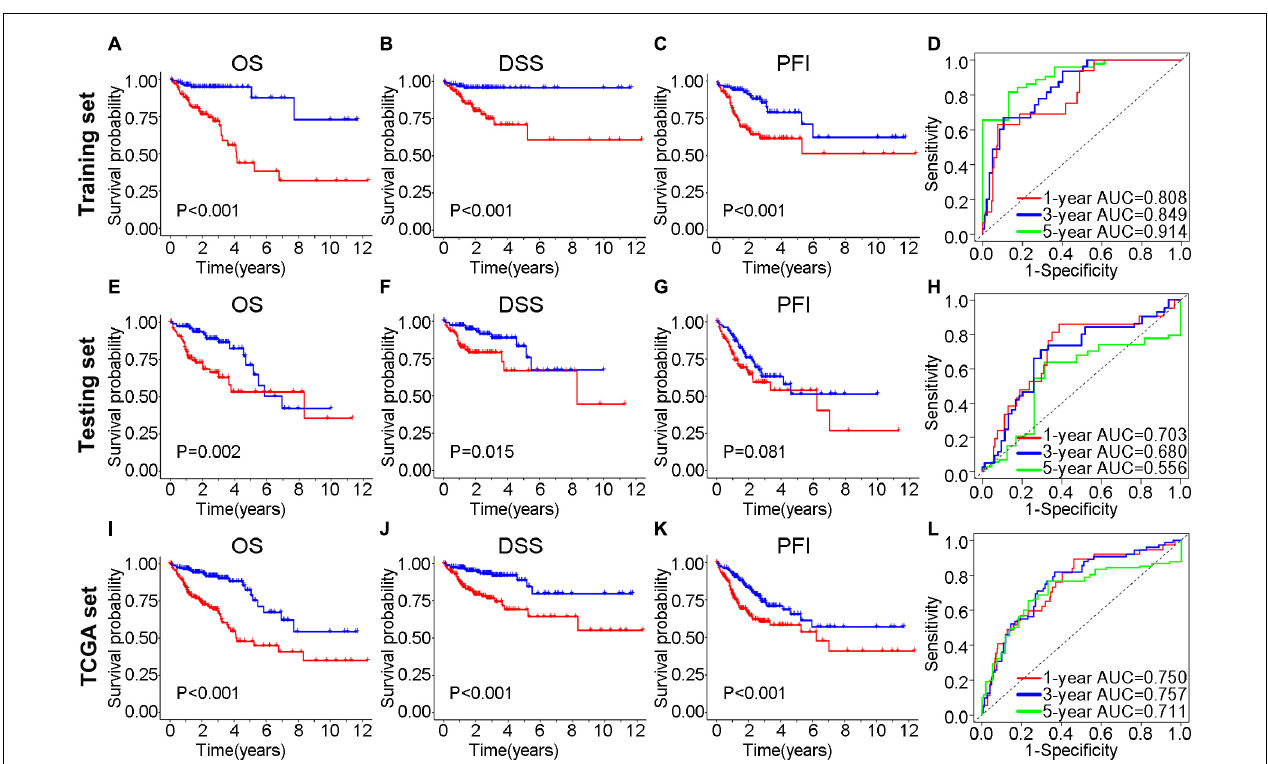
FIGURE 7 | Efficiency validation of the genome instability-associated lncRNA signature for prognostic prediction. In training set, Kaplan–Meier curves for OS (A) , DSS (B) and PFI (C) of patients and the receiver operating characteristic (ROC) curves (D) . In testing set, impact of prognostic risk on OS (E) , DSS (F) and PFI (G) of patients and the ROC curves (H) . In TCGA set, impact of prognostic risk on OS (I) , DSS (J), and PFI (K) of patients and the ROC curves (L) . OS, overall survival; DSS, disease-specific survival; PFI, progression-free interval; AUC, area under the